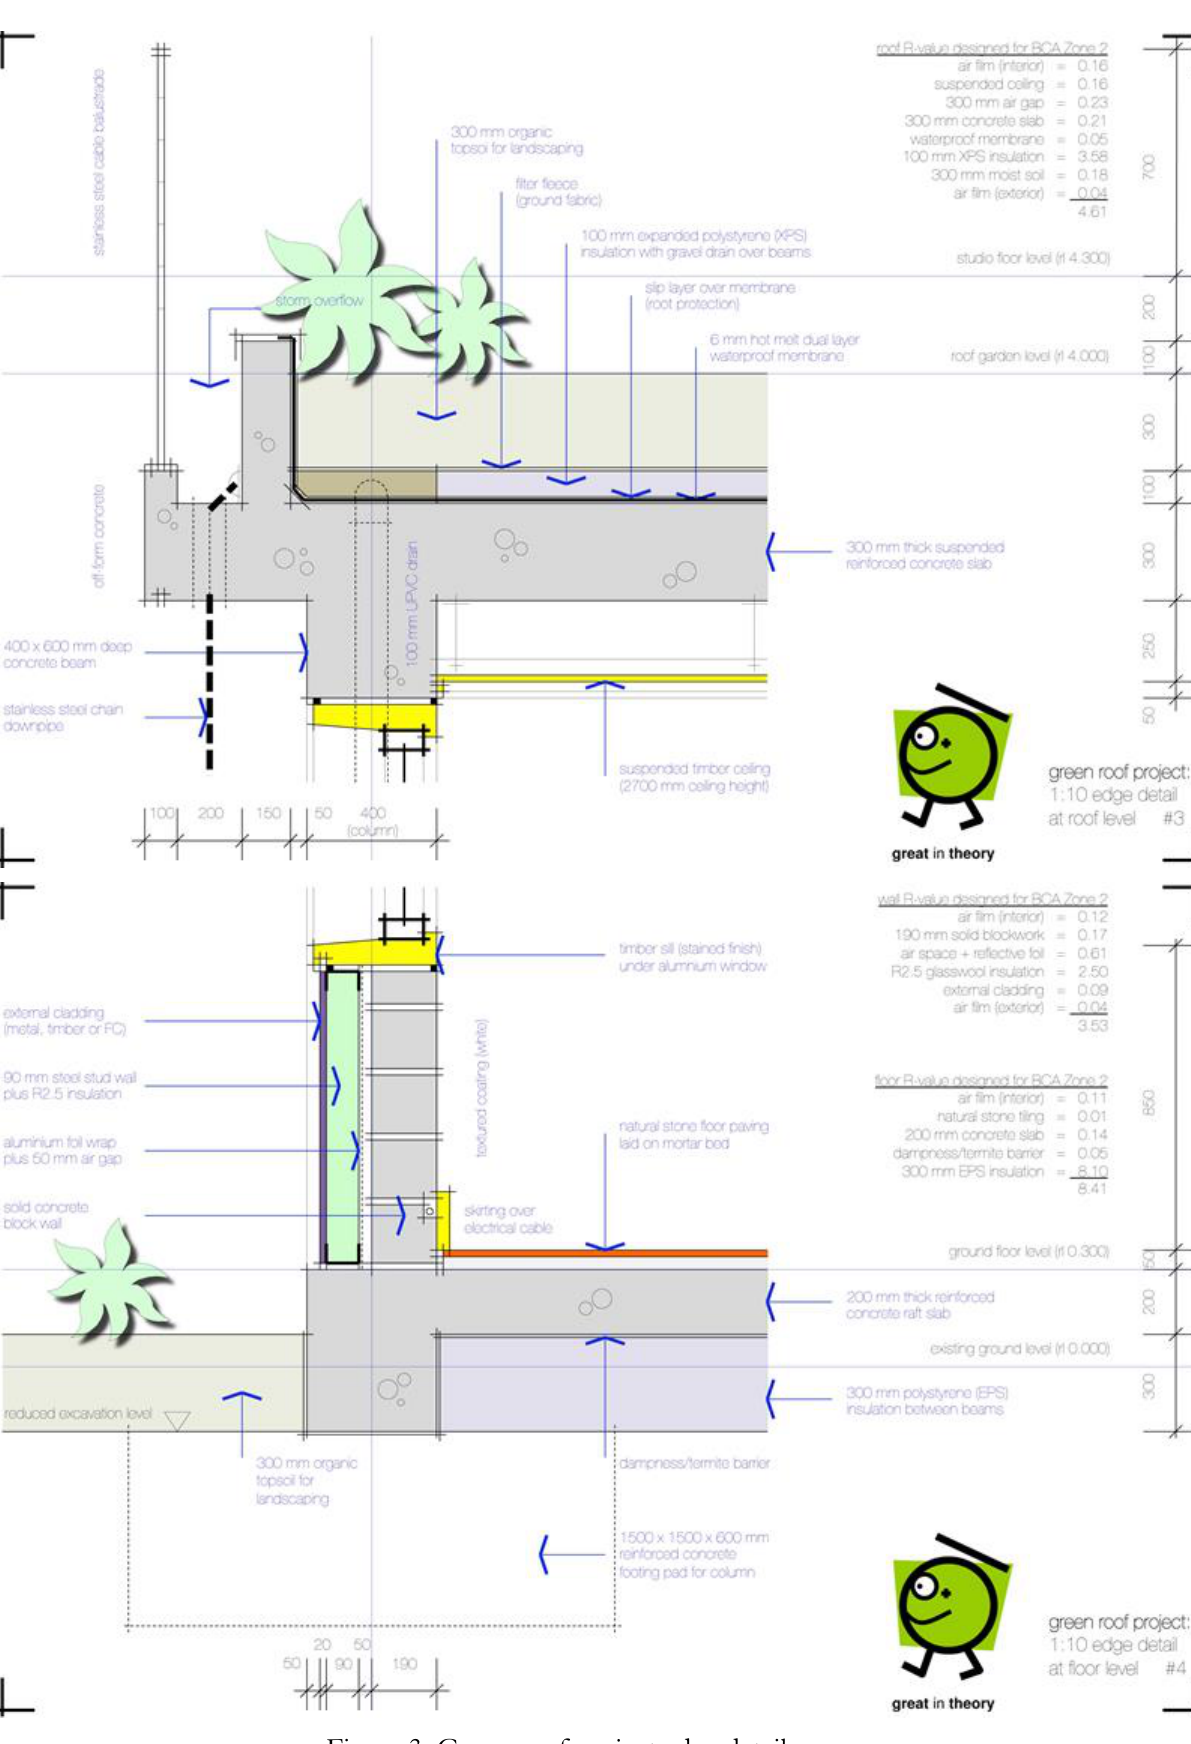
Figure 3: Green roof project edge